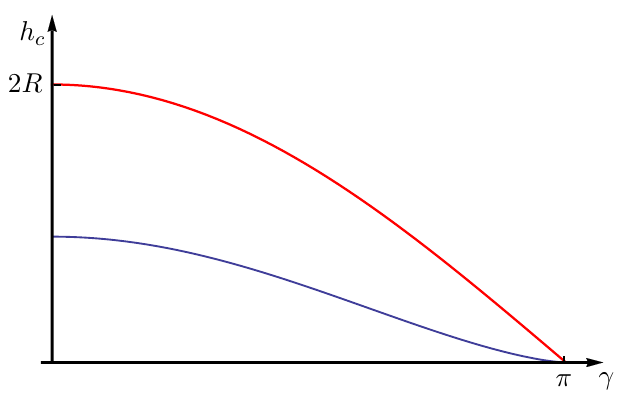
Figure 5 . Critical separation as a function of the internal space angle (cid:13) for the case R 1 = R 2 = R . The blue curve represents the transition between connected/disconnected string con(cid:12)gurations and the red curve represents the transition in the ladder